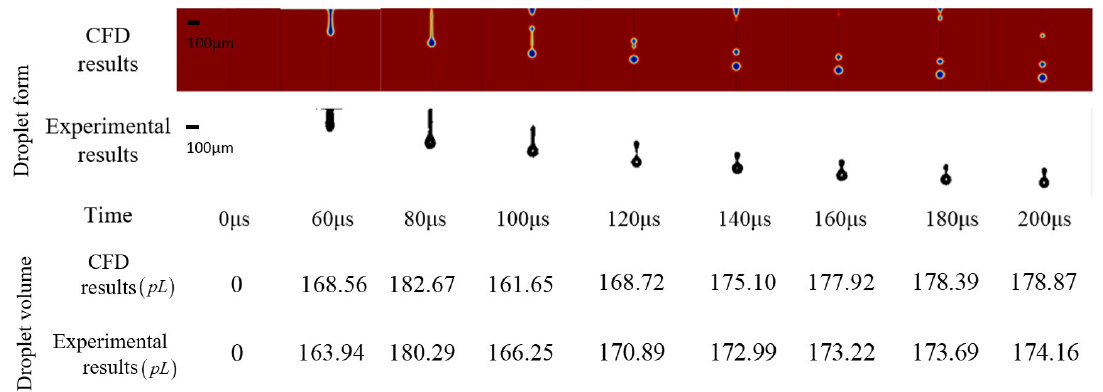
Figure 10. Comparison of xanthan gum solution CFD result and experimental result at the condition of the origin driving waveform.